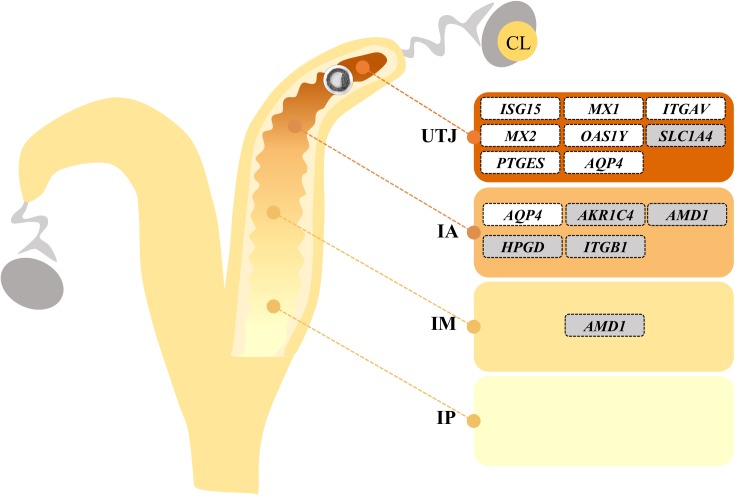
Summary of embryo-dependent effects.Schematic representation of distribution of transcripts affected by Group by Region (UTJ, uterotubal junction; IA, anterior; IM, medial; IP, posterior) interaction in the uterine horn ipsilateral to the CL. The position of each differentially expressed gene in the figure indicate an upregulation (placed inside a white box) or downregulation (placed inside a gray box) in the Pregnant compared to Control cows within each region.